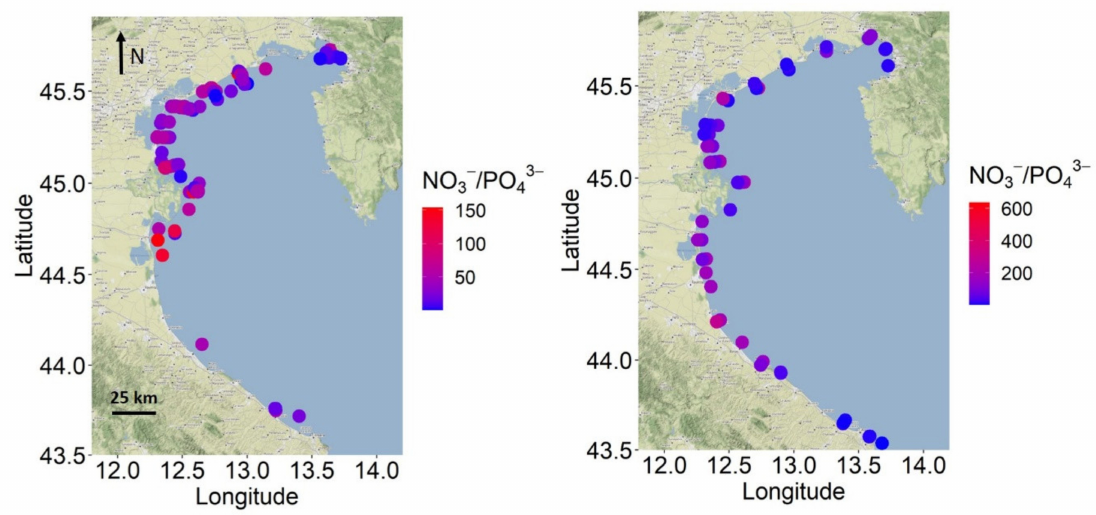
Figure 8. Distribution of nitrate / phosphate ratio within 4.5 miles for the period 1971–2005 ( left ) and 2006–2015 ( right